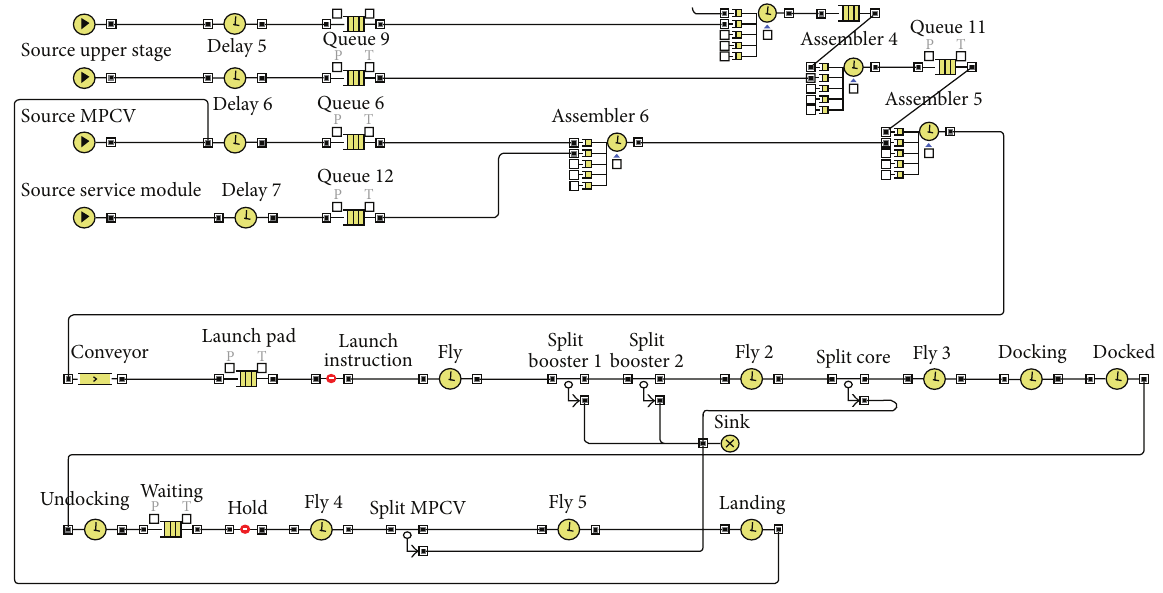
Figure 8: Partial depiction of the discrete-event model for the SLS and MPCV stacking operations inside the VAB using AnyLogic (http://www.anylogic.com/).